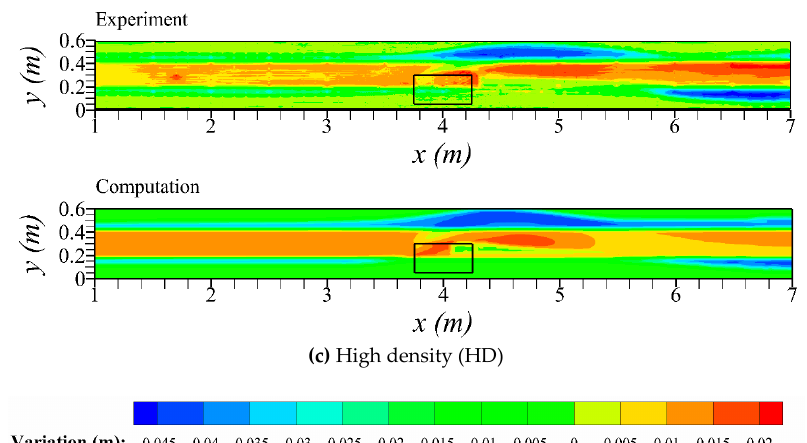
Figure 5. Comparison of variation of bed elevation between experiment and computation for case 3: ( a ) non-vegetated channel; ( b ) low density; ( c ) high density. Flow is from left to right. The solid line is a patch of vegetation.